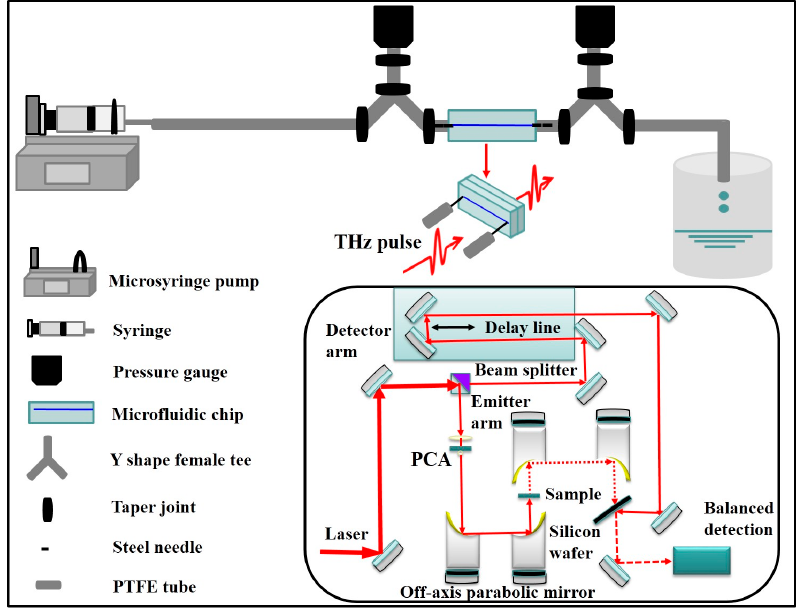
Figure 1. Sketch of the experiment arrangement for detection of deionized water flowing in microchannel with transmission THz-TDS and setup of transmission THz-TDS systems (inset).